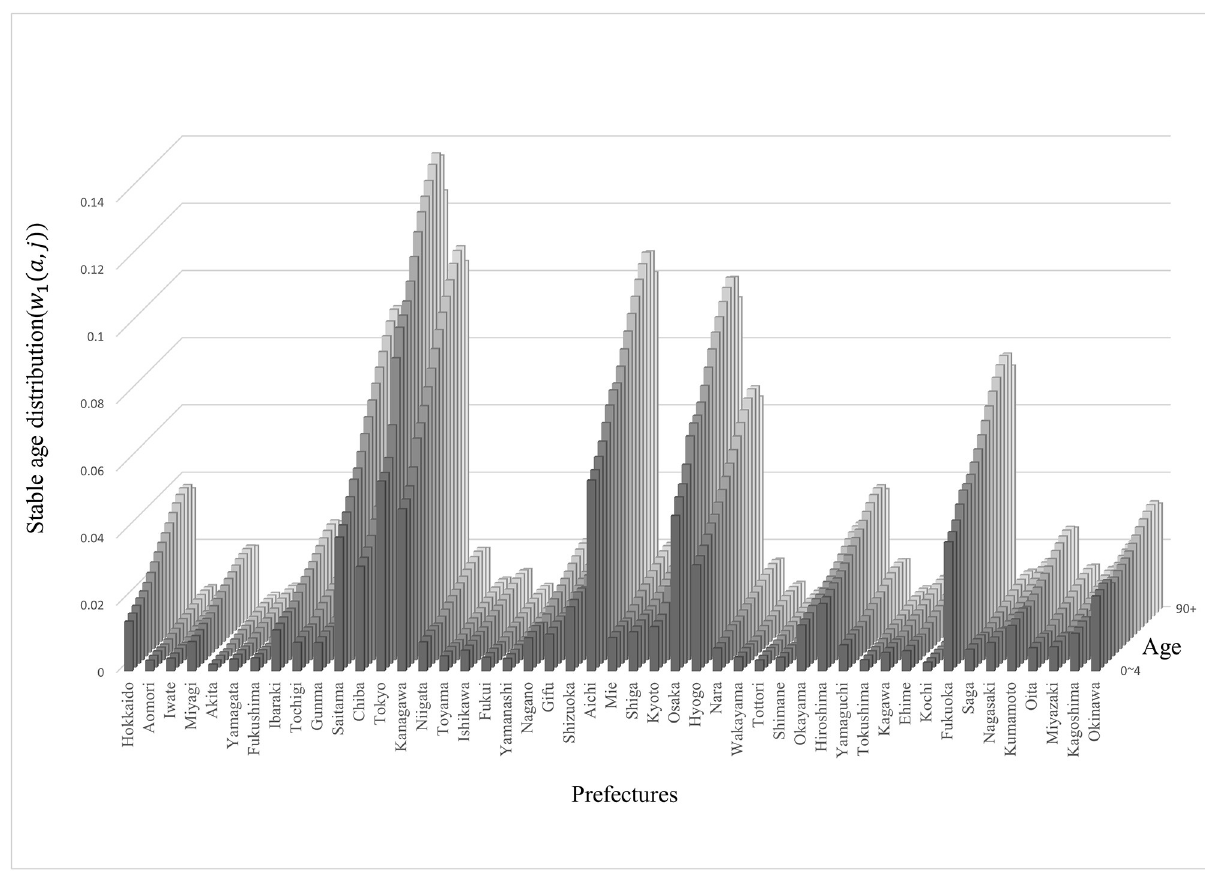
Fig 2. Multi-regional stable age